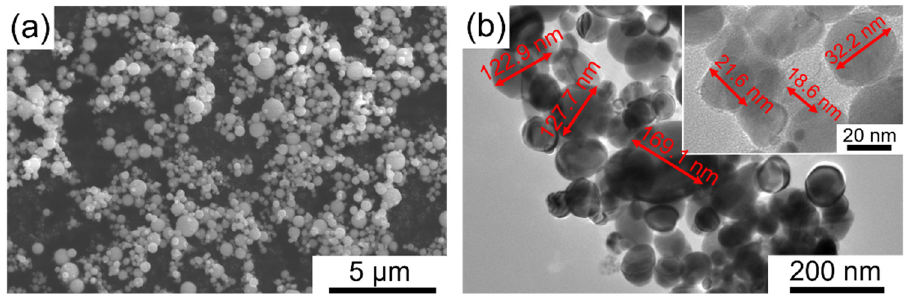
Figure 9. Morphology of the NP-powder: ( a ) SEM image, ( b ) high magnification TEM image.